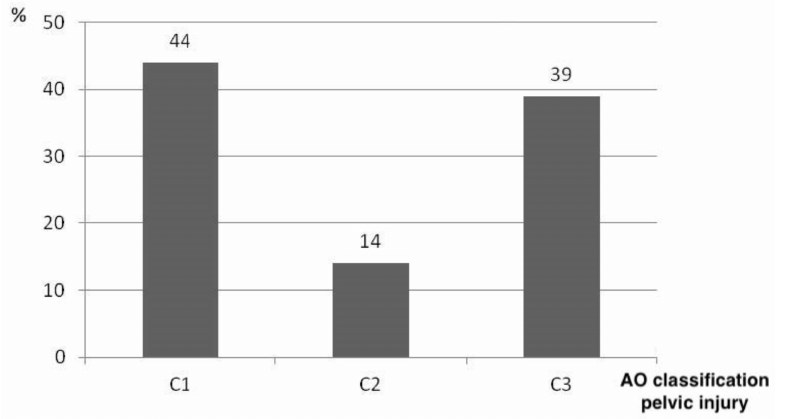
Figure 6. Distribution of type C pelvic injuries of the studied collective. Leading were type-C1 injuries, followed by type-C3 pelvic injuries (source: Haussmann [22], modified).